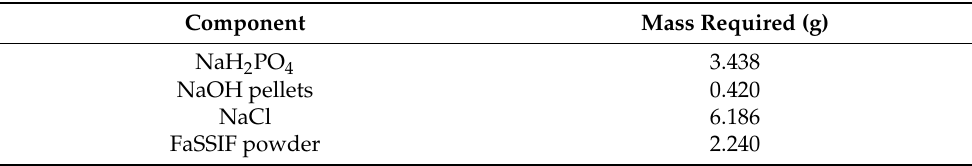
Table 7. Components required for 100 mL of concentrated FaSSIF